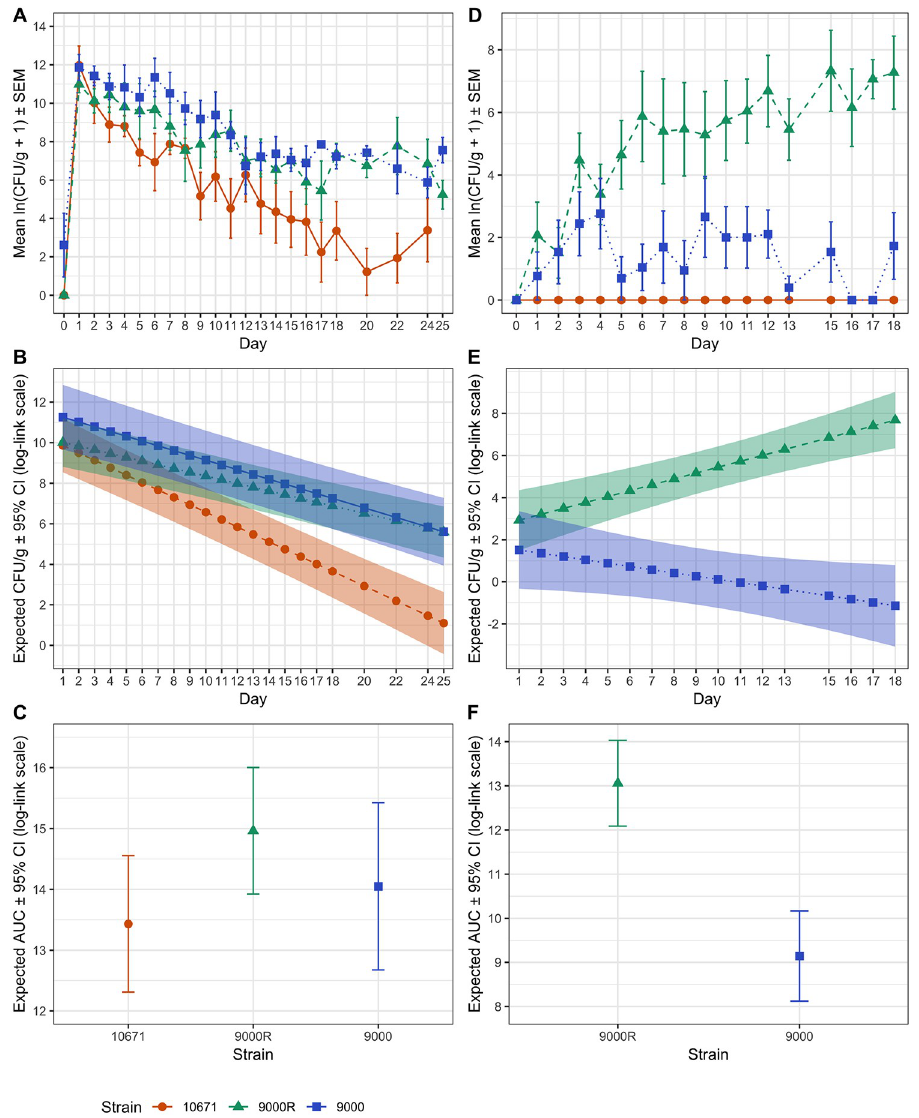
Fig 4. Analysis of shedding and transmission from experimentally challenged and sentinel calves. Shedding data and analysis is shown for experimentally infected calves (A–C) and na ï ve in-contact sentinel calves (D–F). (A) Mean ± SEM daily cfu/g faeces from animals challenged with strains 10671 (n = 4) (red), 9000R (n = 7) (green) and 9000 (n = 6) (blue). (B) Strain specific differences in mean cfu/g over time were determined using a Poisson GLMM. Predicted mean cfu/g values ± 95% confidence interval (CI) bands (in log-link scale) are shown for 10671 (red), 9000R (green) and 9000 (blue). (C) Predicted total shedding for each strain was calculated by AUC analysis. Mean AUC ± 95% CI (in log-link scale) are shown. Equivalent analysis for all sentinel animals infected with strains 10671, 9000R and 9000 by transmission was performed. (D) Mean daily ± SEM cfu/g faeces (in log scale), (E) GLMM predicted mean daily cfu/g ± 95% CI bands (in log-link scale) and (F) negative binomial GLM predicted mean AUC ± 95% CI (in log-link scale) for sentinel animals are